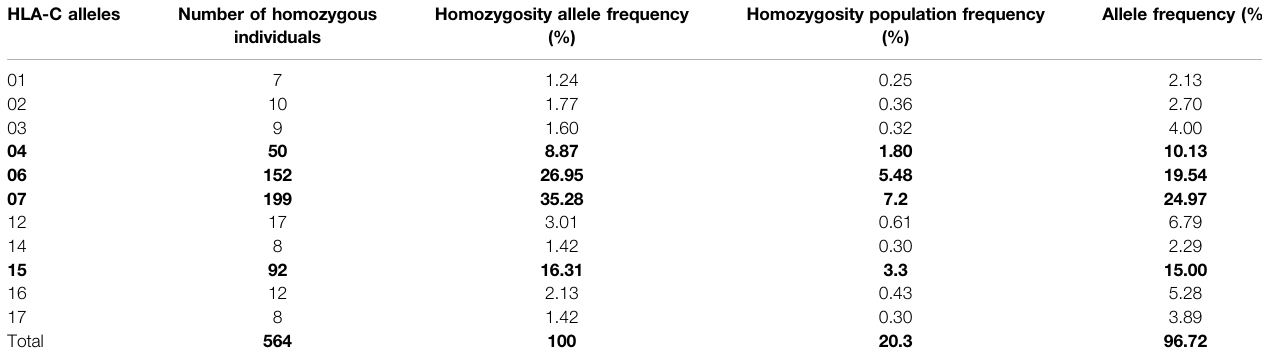
Bold values indicate the highest frequencies.